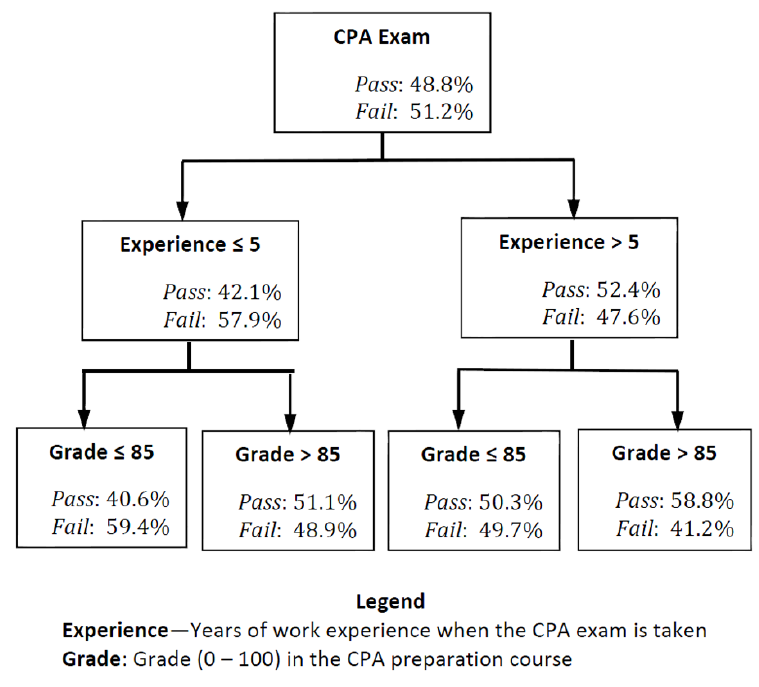
Figure 2. Example of a decision